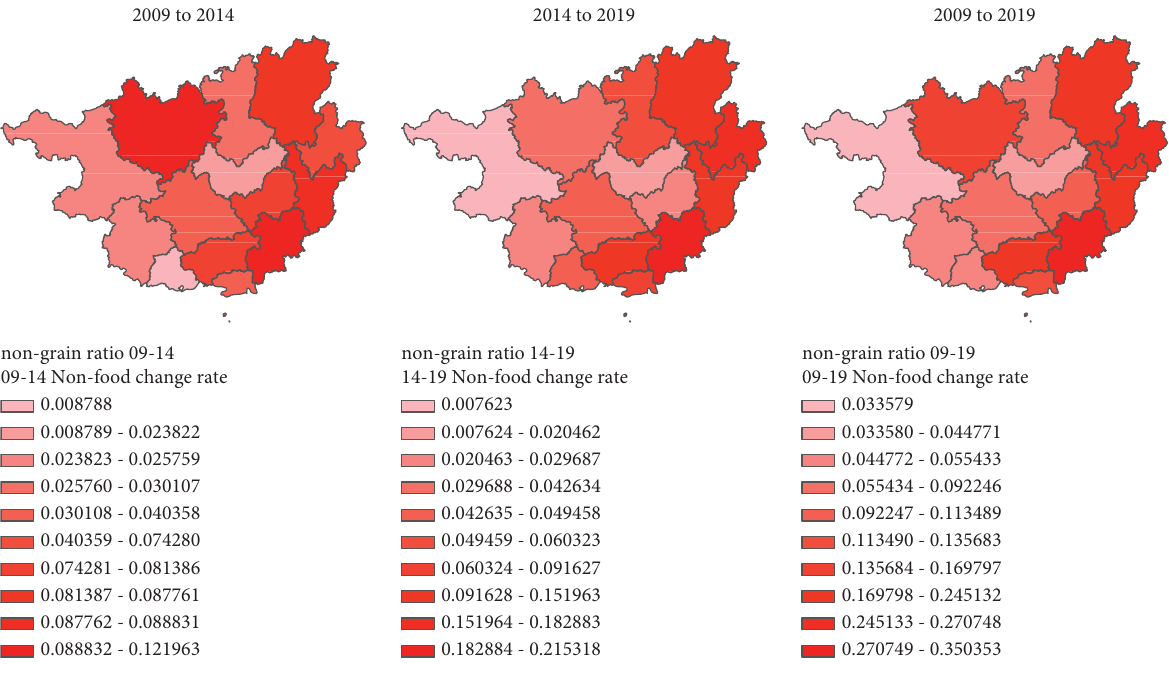
Figure 5: Change rate map of the proportion of nongrain crop planting area in Guangxi from 2009 to